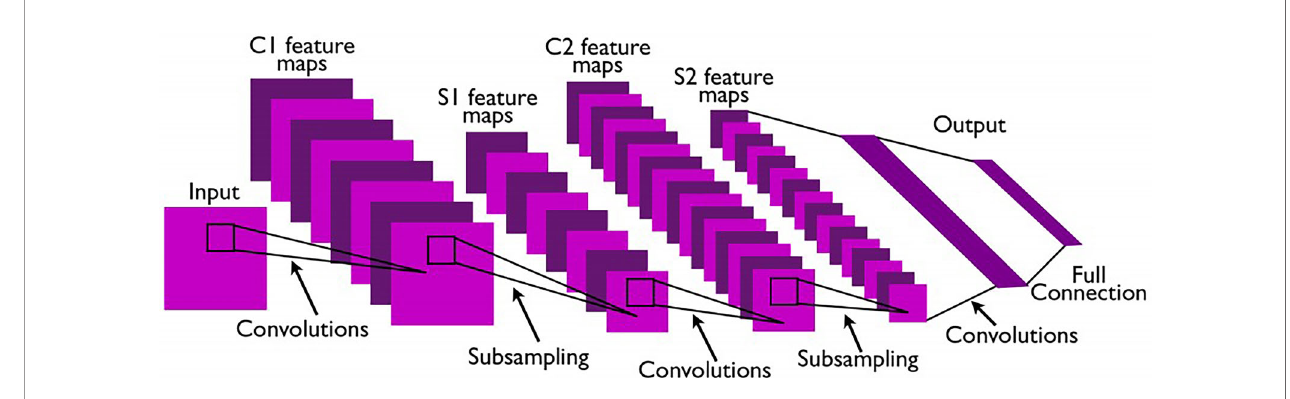
FIGURE 1 | Architecture of a classic